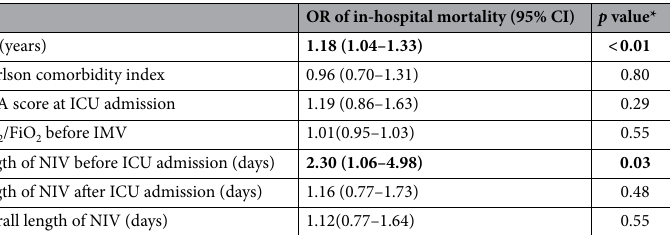
Table 2. Multivariable logistic regression analysis on the association between length of NIV application and in-hospital mortality. Data are expressed as Odds ratios (OR) and 95% Confidence Interval (CI). Bold values are statistically significant. *: Stepwise regression models, which combine forward and backward selection methods in an iterative procedure (with a significance level of 0.05 both for entry and retention) to select predictors in the final multivariable model. Independent variables used in the stepwise approach were selected considering their clinical relevance. SOFA: sequential organ failure assessment; ICU: intensive care unit; PaO 2 / FiO 2 : ratio between partial pressure of arterial oxygen and fraction of inspired oxygen; NIV: non-invasive ventilation; IMV: invasive mechanical ventilation.